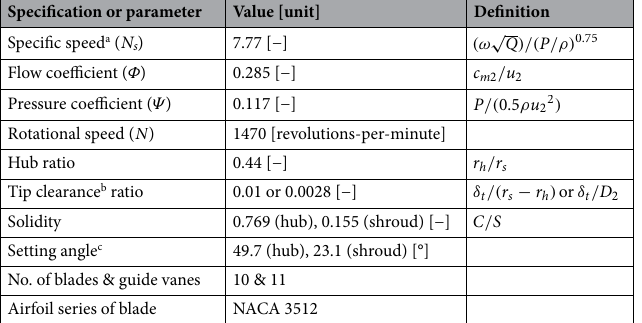
Table 1. Design specifications and parameters of the axial fan. a Type number. b Between a blade tip and casing. c Tangential